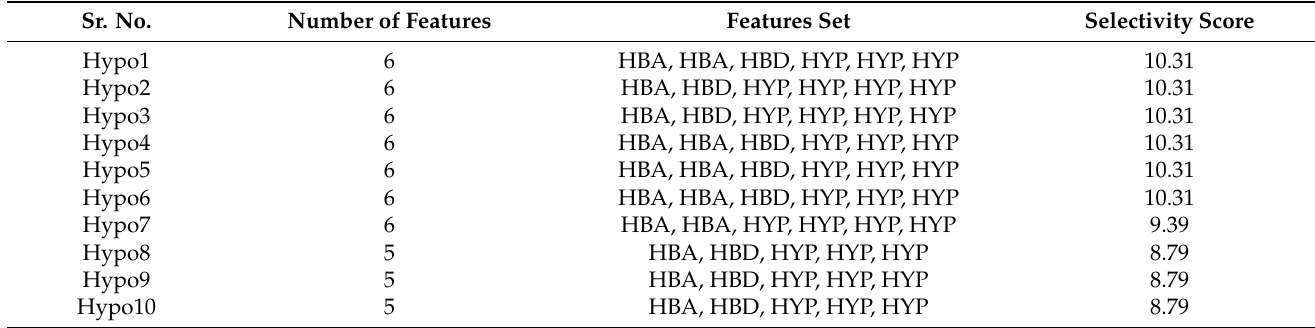
a specificity value of 0.75, 0.75, and 0.87 in terms of identifying inactive compounds; there- fore, these hypotheses were initially selected for further study (Table S2 and Figure S1).